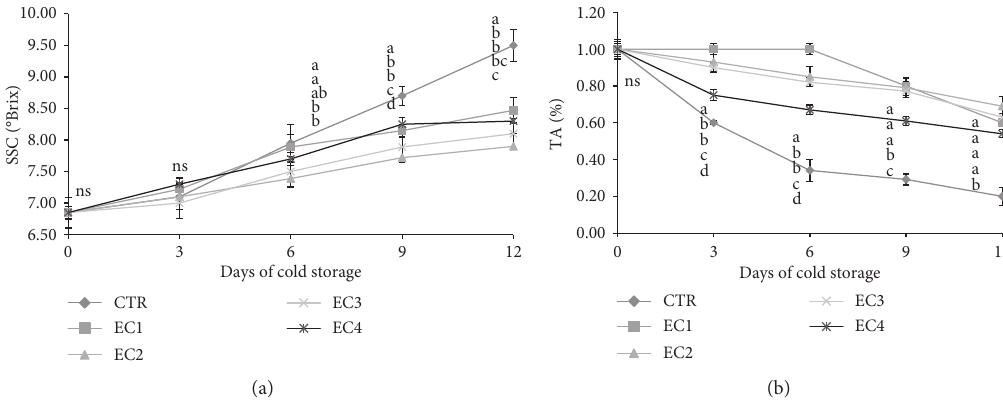
Figure 2: Trend in the soluble solid content ( ° Brix) and titratable acidity (%) of fresh-cut stored papaya. Values were recorded at 0, 3, 6, 9, and 12 days at 5 ° C and RH 90%. Significant values are indicated with equal letters in each